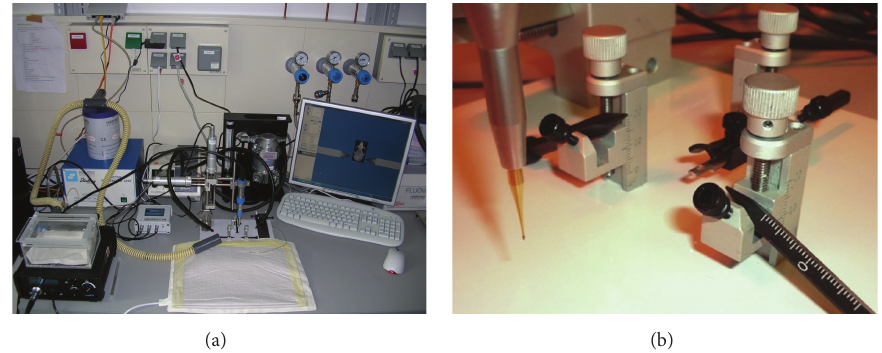
Figure 2: Anesthesia and stereotaxic setup for mice and rats. (a) Gas anesthesia system using isoflurane. A precision high-speed dental drill is mounted on a 3D stereotaxic device for mice and rats, respectively. Supplemental warmth is given using a heating pad. (b) Close-up of drill, stereotaxic ear bars, and nose